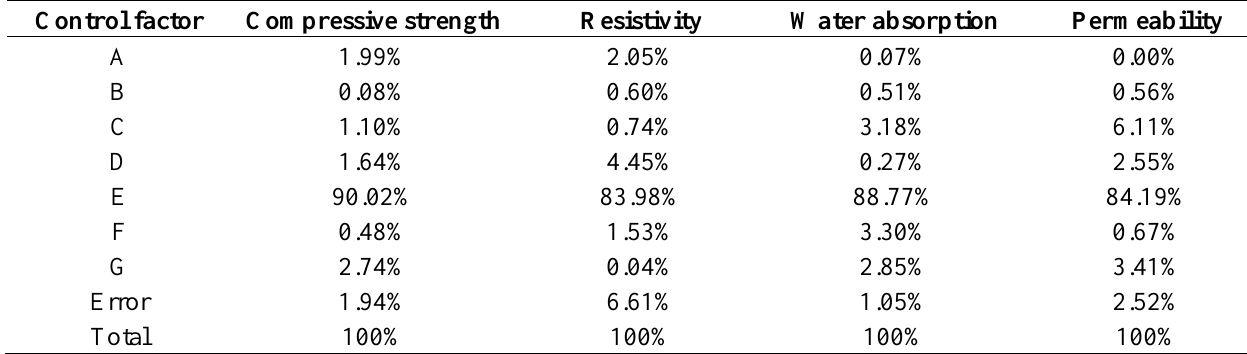
Table 6. Results of ANOVA for contribution ratio.